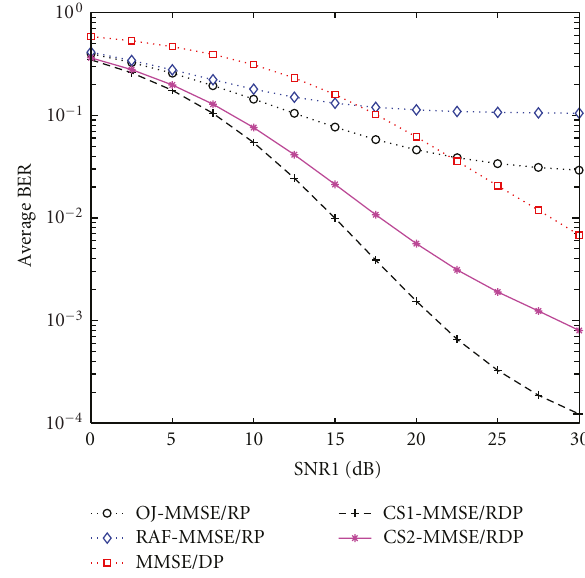
Figure 3: BER versus SNR of BS-RS link in downlink ( p = 0 . 4, SNR2 = 15dB) .